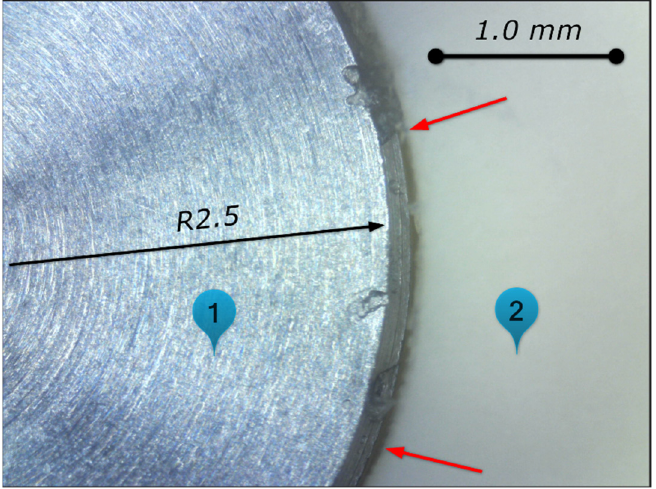
Figure 16. T5 MC#2 styli damage—lack of glue joint around sleeve and ceramic disc. 1—sleeve area,